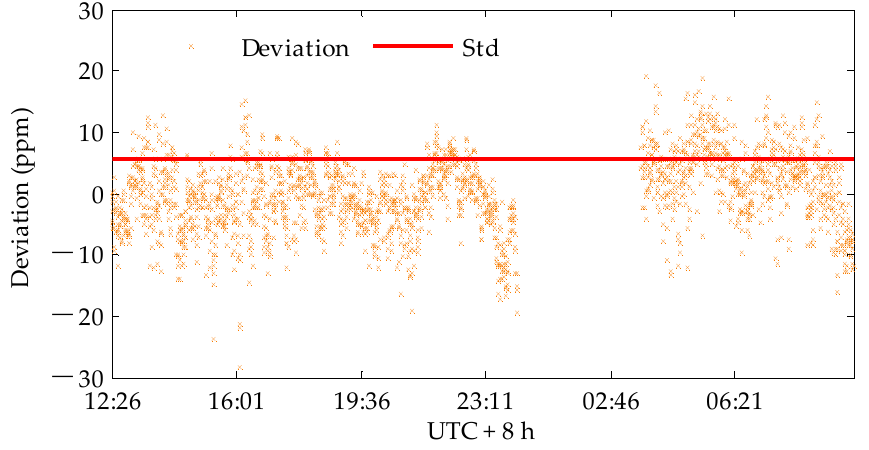
Figure 18. The discrepancy between the measured CO 2 concentration by the IPDA system and in situ